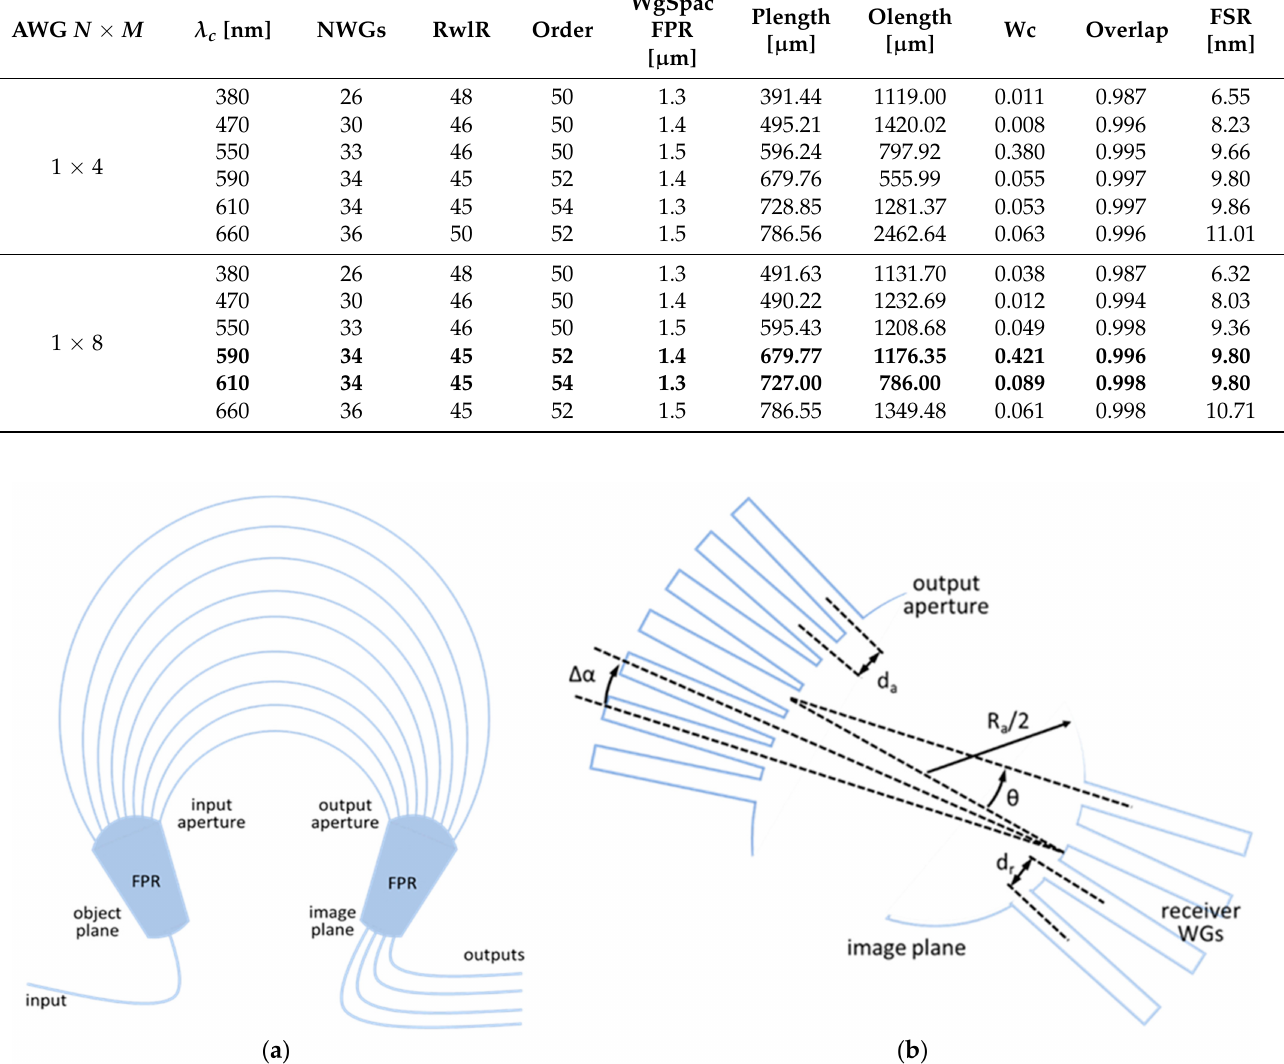
Figure 4. Geometry of AWG: ( a ) layout of arrayed waveguide grating; ( b ) geometry of output star